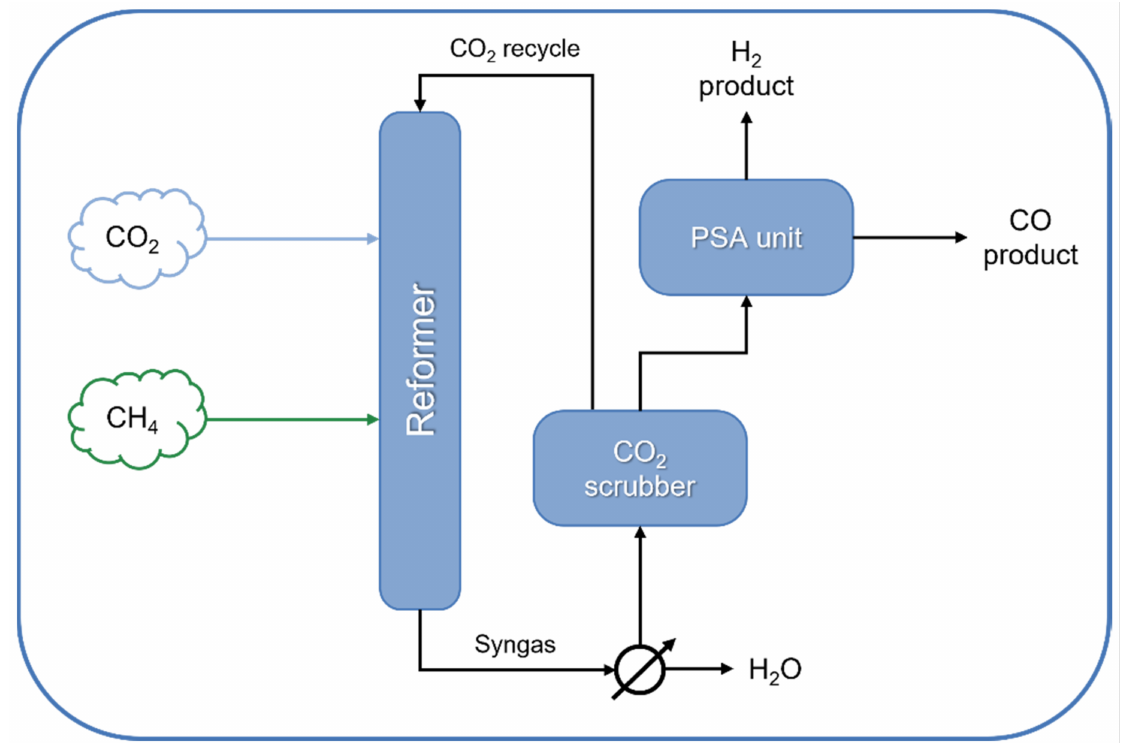
Figure 7. Simplified block diagram of the CALCOR™ process for CO production [155]. PSA—Pressure swing